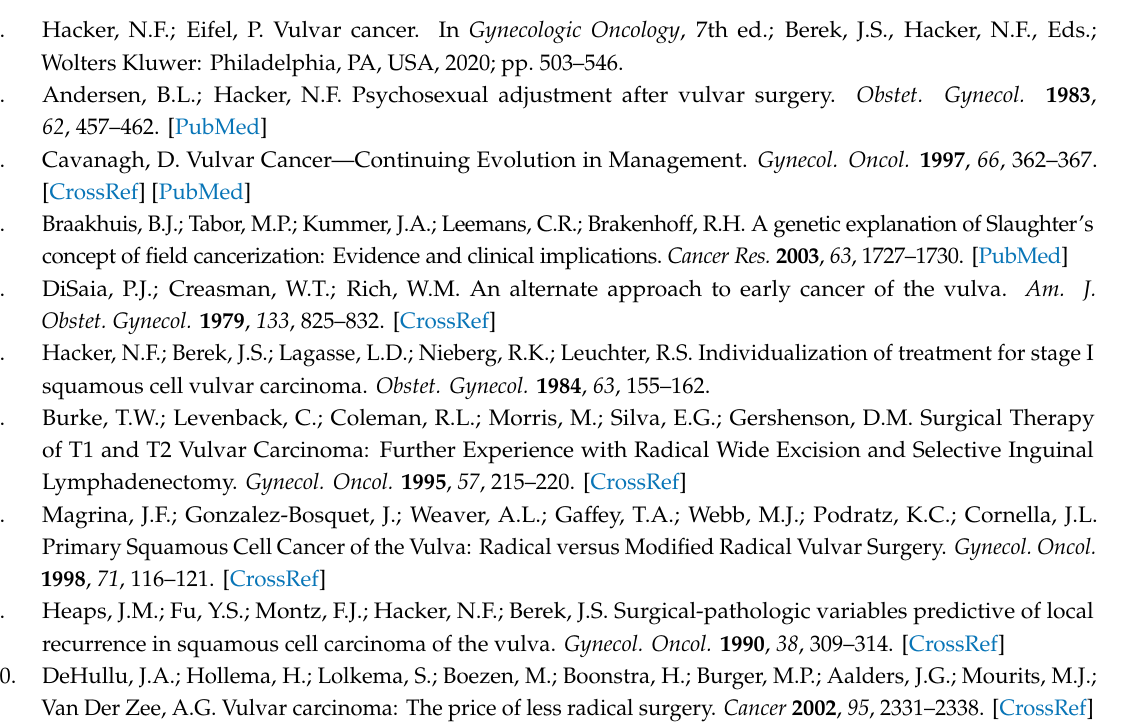
Figure S1. Kaplan–Meier curve for ten-year disease specific survival for the whole study cohort; Figure S2. Kaplan–Meier curve for ten-year disease-specific survival for patients with positive nodes; Figure S3. Kaplan–Meier curve for ten-year disease-specific survival stratified by site of first recurrence; Figure S4. Kaplan–Meier curve for ten-year overall survival for the total study cohort; Figure S5. Local recurrence rate in margins ≥ 8 mm compared to margins < 8 mm; Table S1. margin distance and treatment of positive or close margins to site of vulvar recurrence; Table S2. Breakdown of vulvar recurrence per mm margin distance in 25 patients with untreated margins < 5